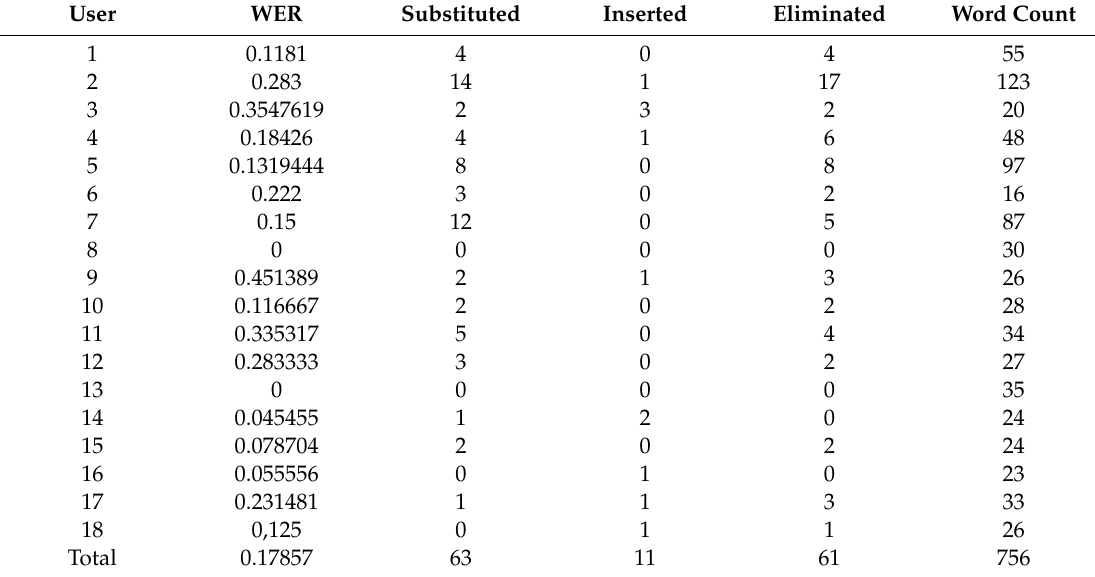
Table 2. Translation WER results, for all participants and global result.